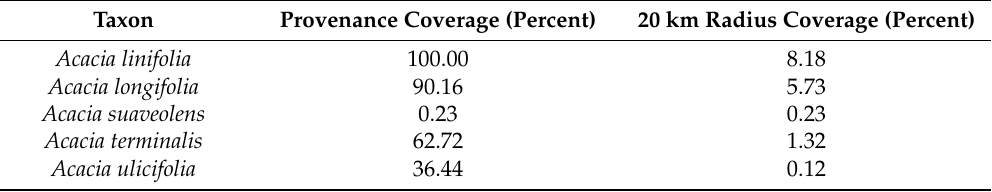
Figure 5. Boxplots of genetic diversity indices for the five Acacia tested. Allelic richness (ar), number of private alleles (n_pa), observed and expected heterozygosity, inbreeding coefficient (Fis) and between population divergence (Fst) are displayed. Table 2. Coverage of observed genetic variation across the five Acacia species captured by geographic regions defined by using a GDM, and a generic 20 km radius around the same target site. Coverage was computed as the ratio between the area of a convex hull around samples on a plot of PC1 and PC2, and the area of the convex hull around samples falling within the